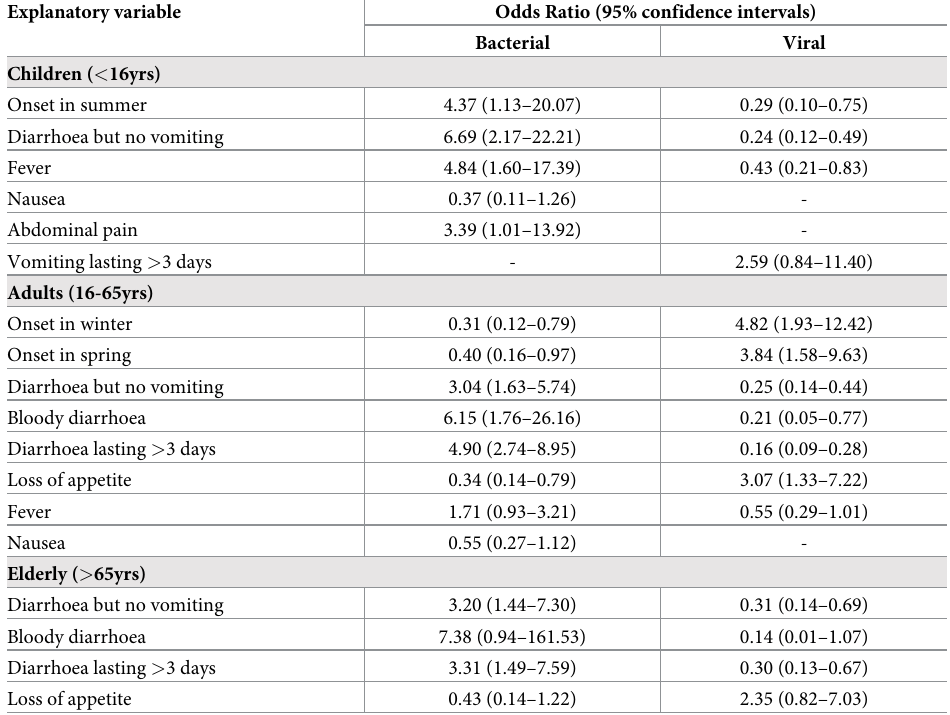
Table 4. Multivariable logistic regression model outputs (Odds Ratio with 95% confidence intervals) for bacterial and viral pathogens, by age